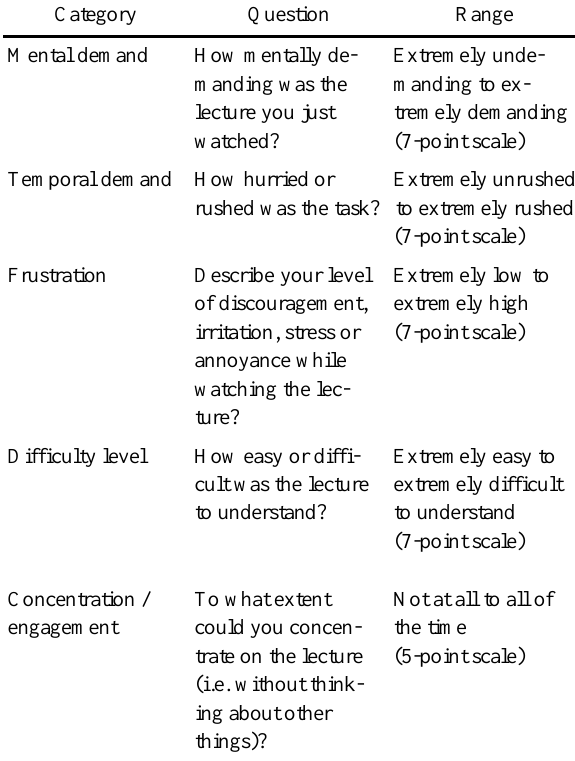
Table 2. Self-report questionnaire on task